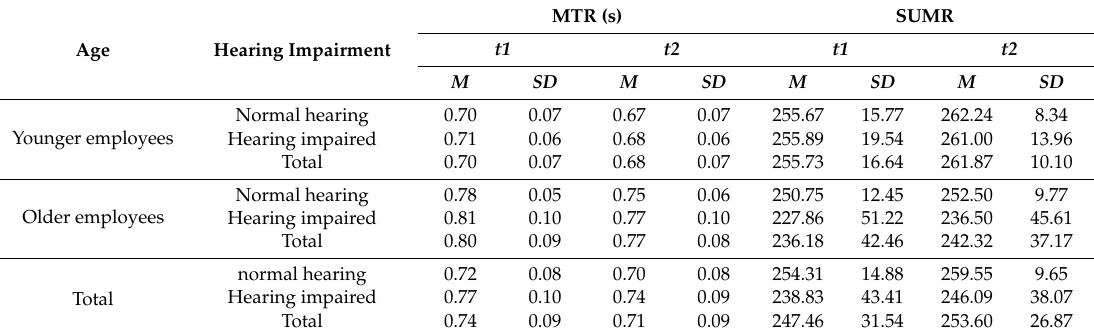
Table 1. Descriptive statistics—long-term selective attention and concentration.